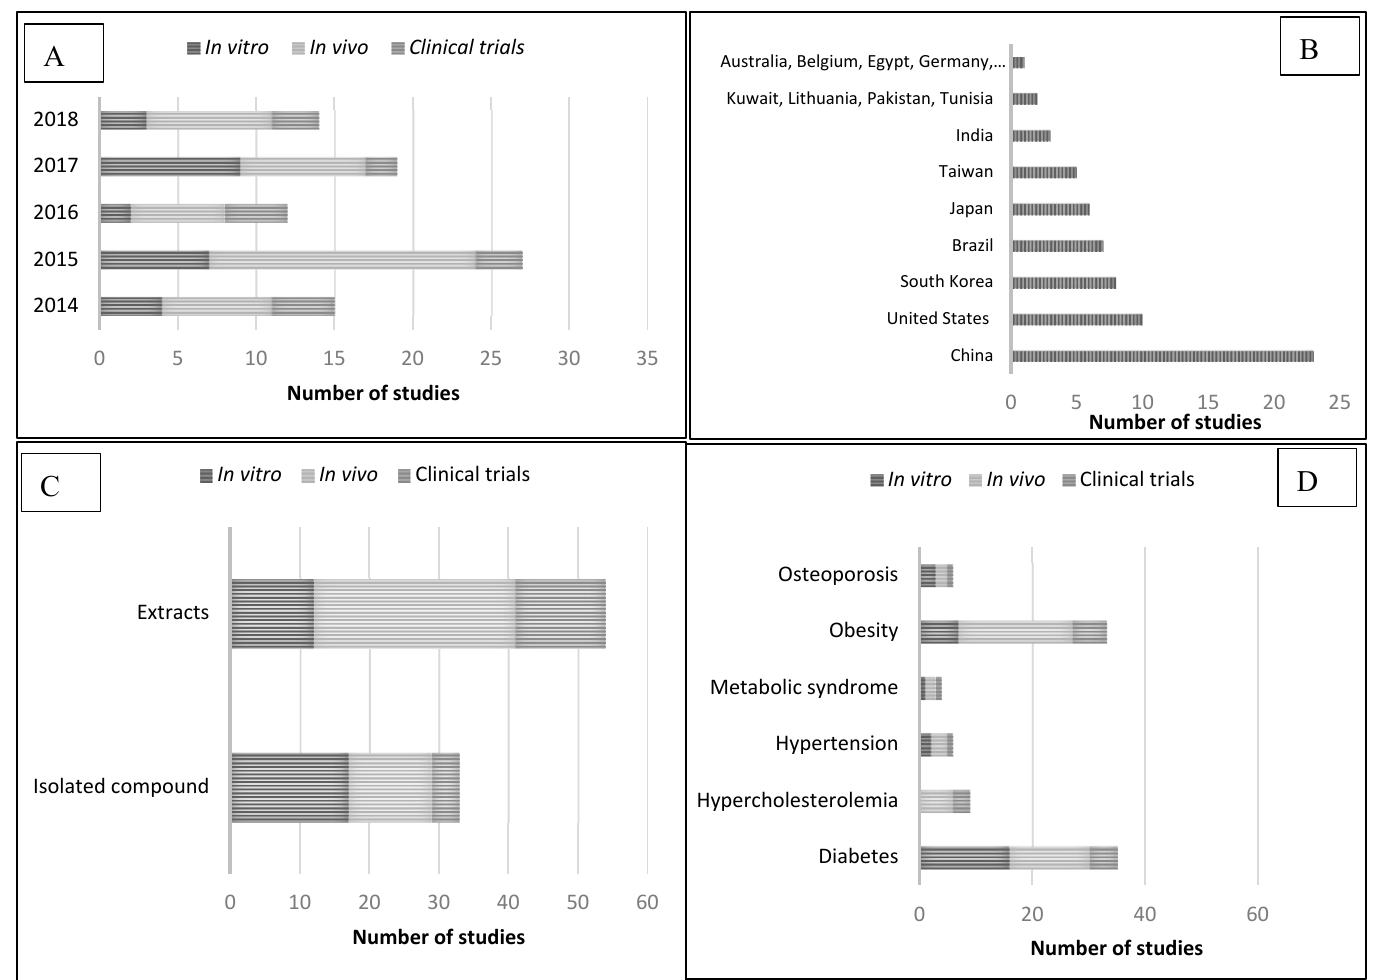
Figure 2. Main characteristics of papers published on pharmacological activity of Camellia sinensis. ( A ) Year of publication. ( B ) Research group country. ( C ) Part of the plant used for research. ( D ) Diseases studied in in vitro , in vivo , and clinical trials studies.